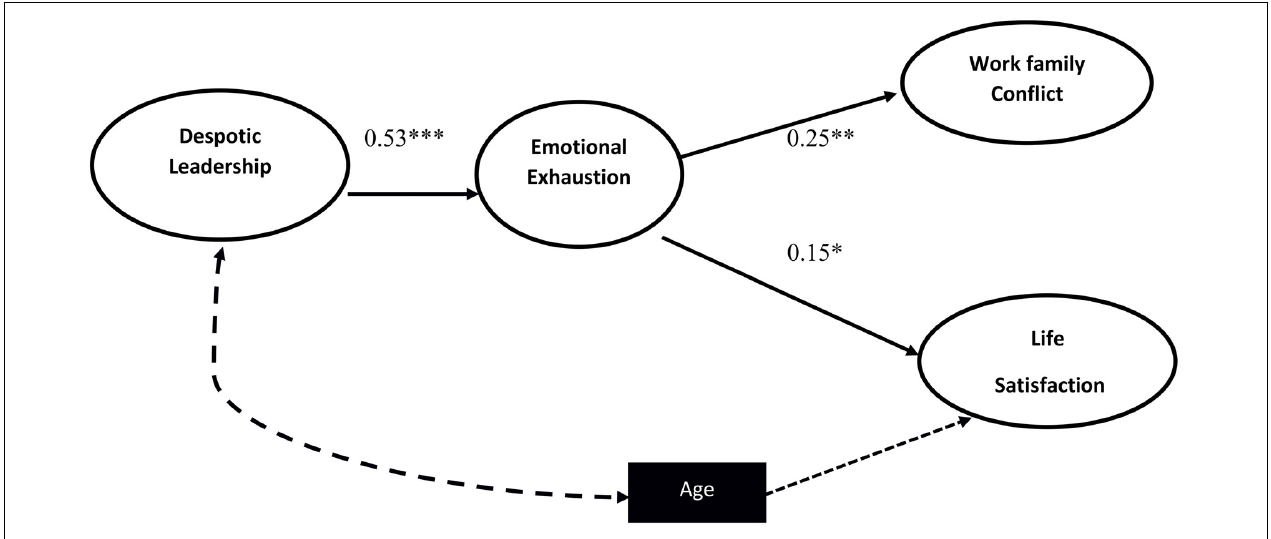
FIGURE 2 | Hypothesized Mediation Model. N = 224. DL, Despotic Leadership; EE, Emotional Exhaustion; TA, Trait Anxiety; LS, Life Satisfaction. Age is controlled for Despotic Leadership and Life Satisfaction.